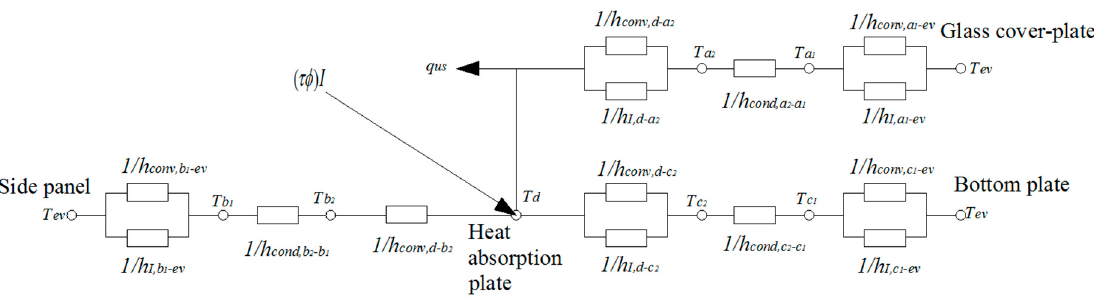
Figure 5. Network chart of the heat transfer resistance of a flat-plate solar collector.